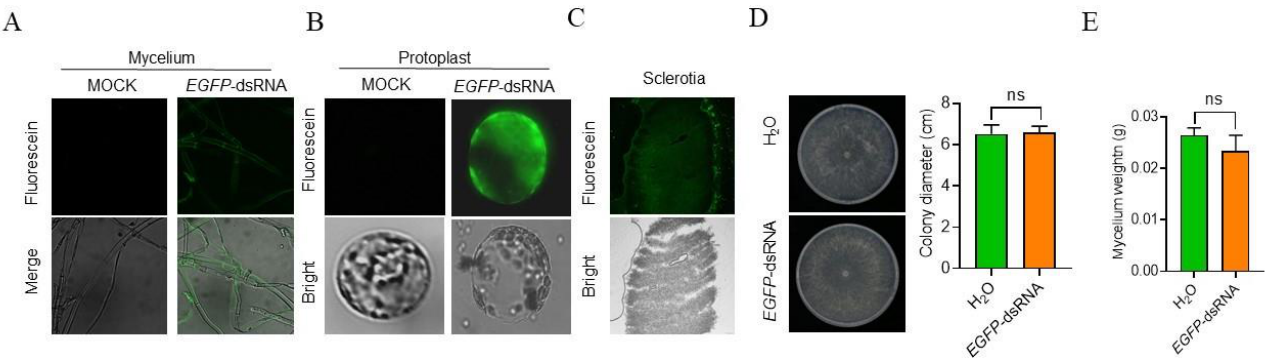
Figure 1. EGFP -dsRNA uptake ability of R. solani . ( A ) Mycelial blocks of R. solani were inoculated on a sterile cellophane placed on potato dextrose agar medium and sprayed with fluorescein-labeled EGFP -dsRNA. Strong fluorescent signals were observed in the mycelia growing on the cellophane 24 h later. ( B ) Mycelia collected from the cellophane were treated with a mixture of lywallzyme and driselase for 3 h, and the protoplasts were collected for observation under a confocal microscope. Fluorescein signals inside the protoplasts meant that dsRNA had entered R. solani cells. ( C ) Mycelia on the cellophane formed sclerotia 4 days after inoculation. Fluorescein signals are also observed in the inner cells of the sclerotia. ( D ) Colony of R. solani in the sterilized cellophanes placed on PDA medium and sprayed with dsRNA. ( E ) Weight of mycelia collected from the sterilized cellophane. ns: no significant differences.